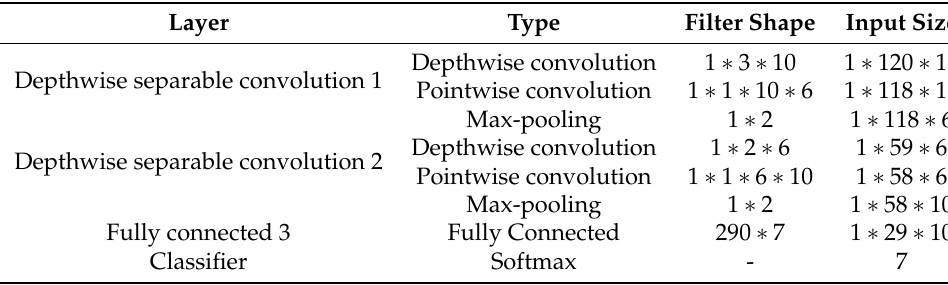
Figure 3. The OI-DSCNN model. Table 1. the OI-DSCNN model